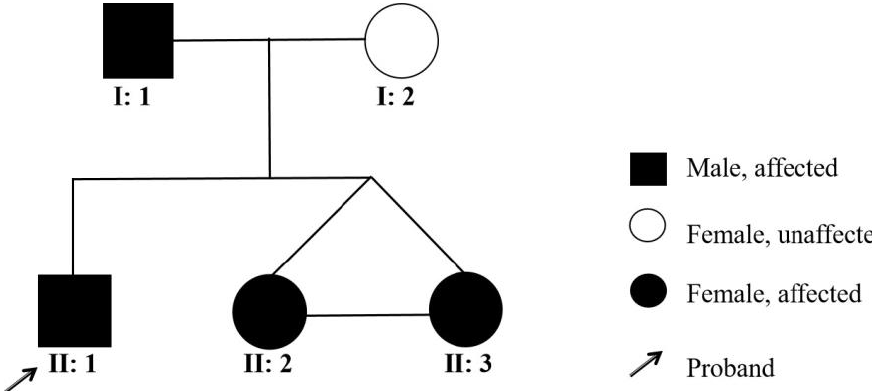
Figure 5. Pedigree of the proband’s family.